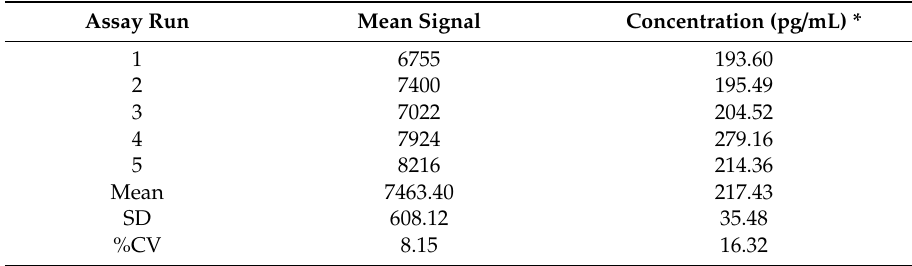
Table 2. Day-to-day variance of the A β − 3–40